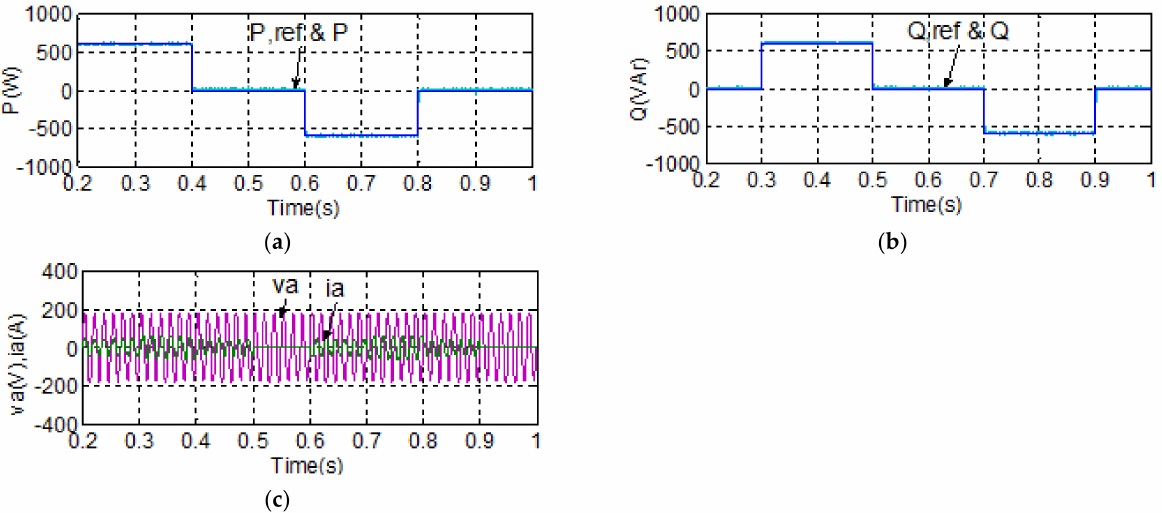
Figure 18. Simulated MG inverter waveforms in case 2: ( a ) active power and reference; ( b ) reactive power and reference; ( c ) phase-a voltage and current.